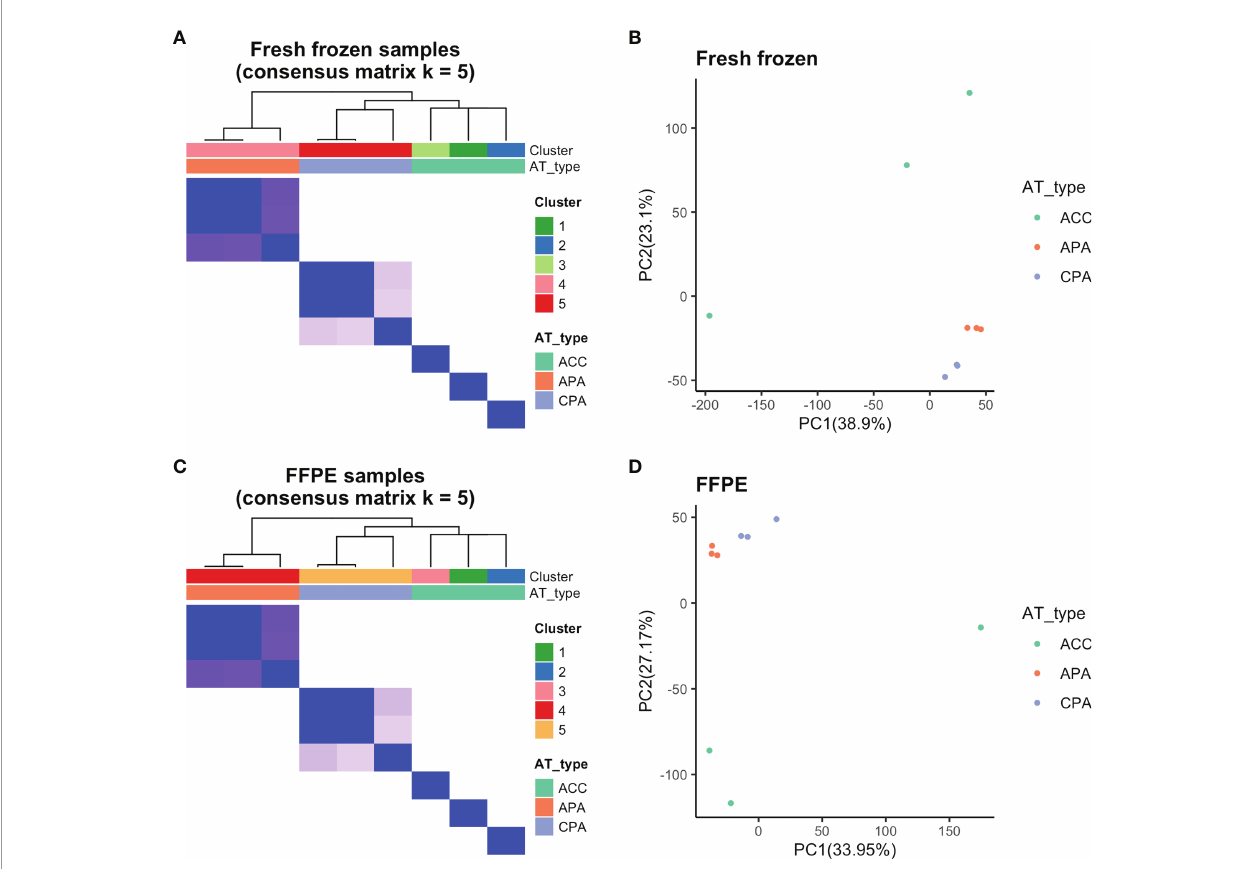
FIGURE 2 | Results of consensus clustering and principal component analysis. (A) Fresh frozen samples were divided into fi ve clusters by consensus clustering (Cluster 1-3: ACC, Cluster 4: APA, Cluster 5: CPA samples). (B) Principal component analysis of fresh frozen samples con fi rmed separation based on tumor types. (C) By consensus clustering, FFPE samples were also divided into fi ve clusters (Cluster 1-3: ACC, Cluster 4: APA, Cluster 5: CPA samples) similar to fresh frozen samples. (D) Principal component analysis of FFPE samples con fi rmed separation based on tumor